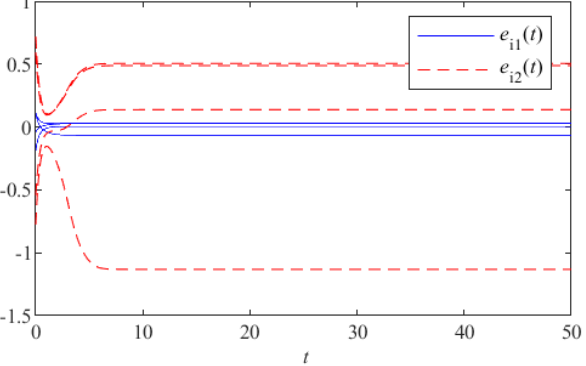
Figure 3. e i ( t ) with the control gains d = 0.49 and k = 0 in Example